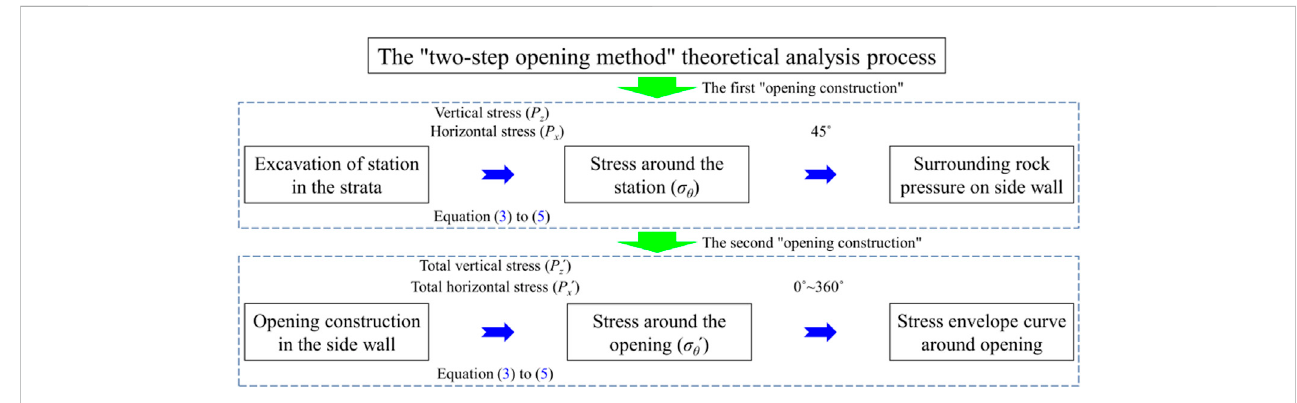
FIGURE 15 Theoretical analysis process of the “ two-step opening ” method.